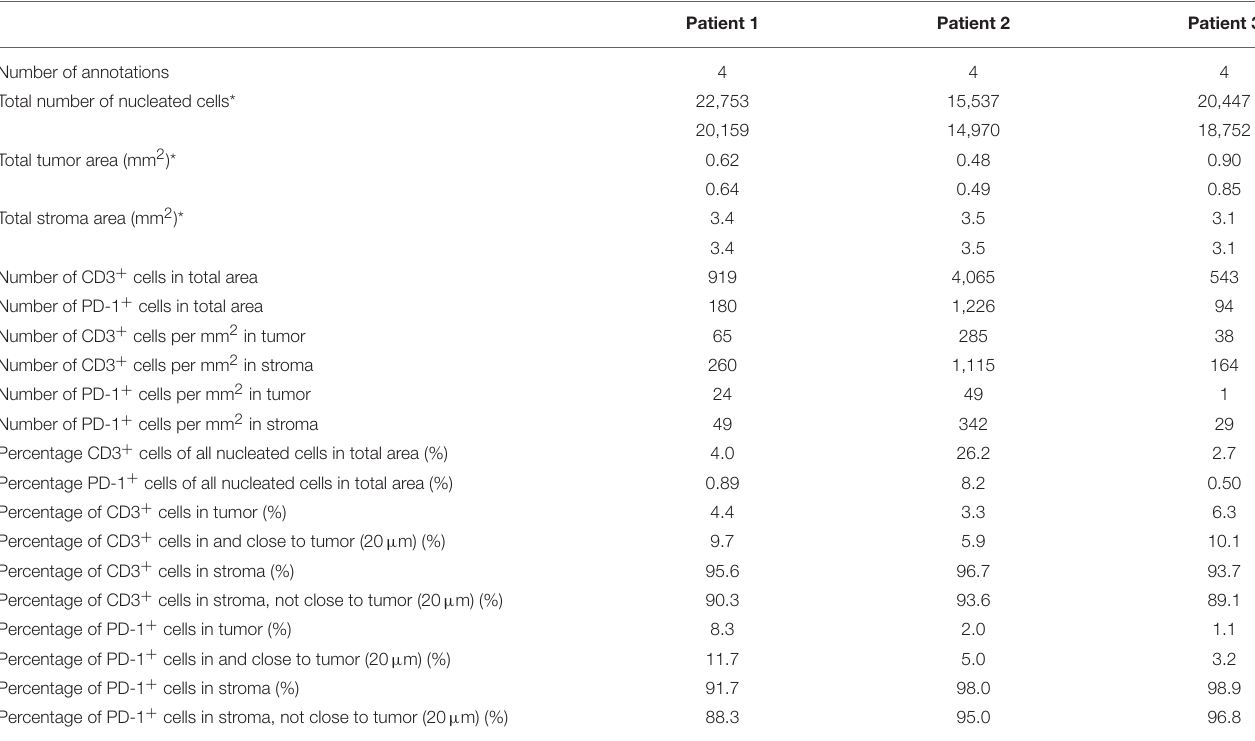
TABLE 2 | Computational analysis of immunohistochemistry stainings.